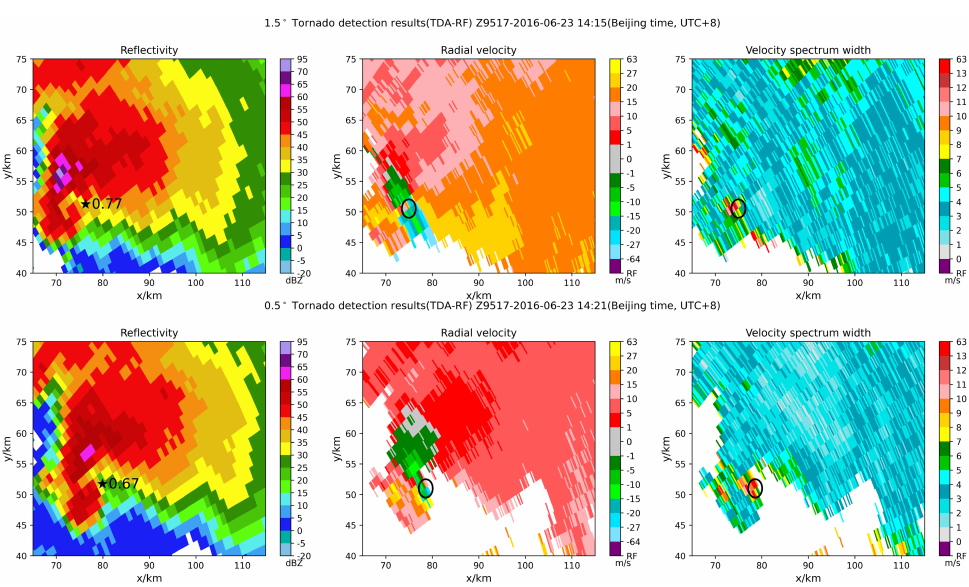
Figure A2. 1.5 ◦ and 0.5 ◦ Tornado early warning results (TDA-RF), Z9517-2016-0623 14:15 and 14:21 (UTC+8), the tornado was EF4. (asterisk corresponds to the identification center, and the value corresponds to the probability; the black circle has a radius of 1.5 km centered on the identification